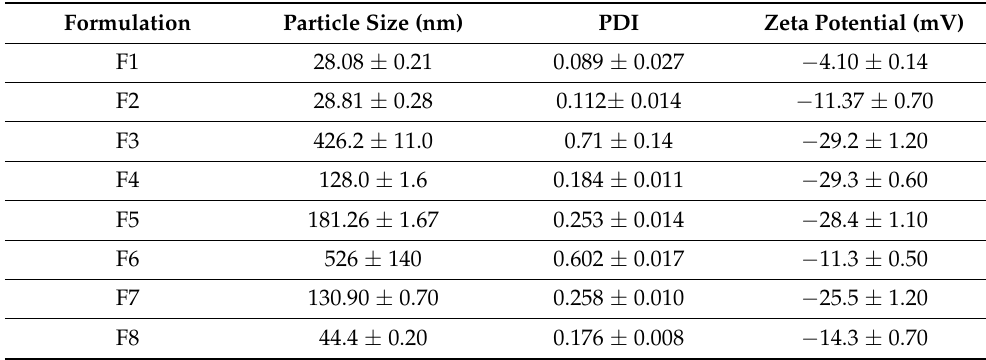
Table 3. Mean particle size and PDI values of the different propofol-loaded liquid SNEDDS formula- tions. Data are expressed as mean ± SD, n =